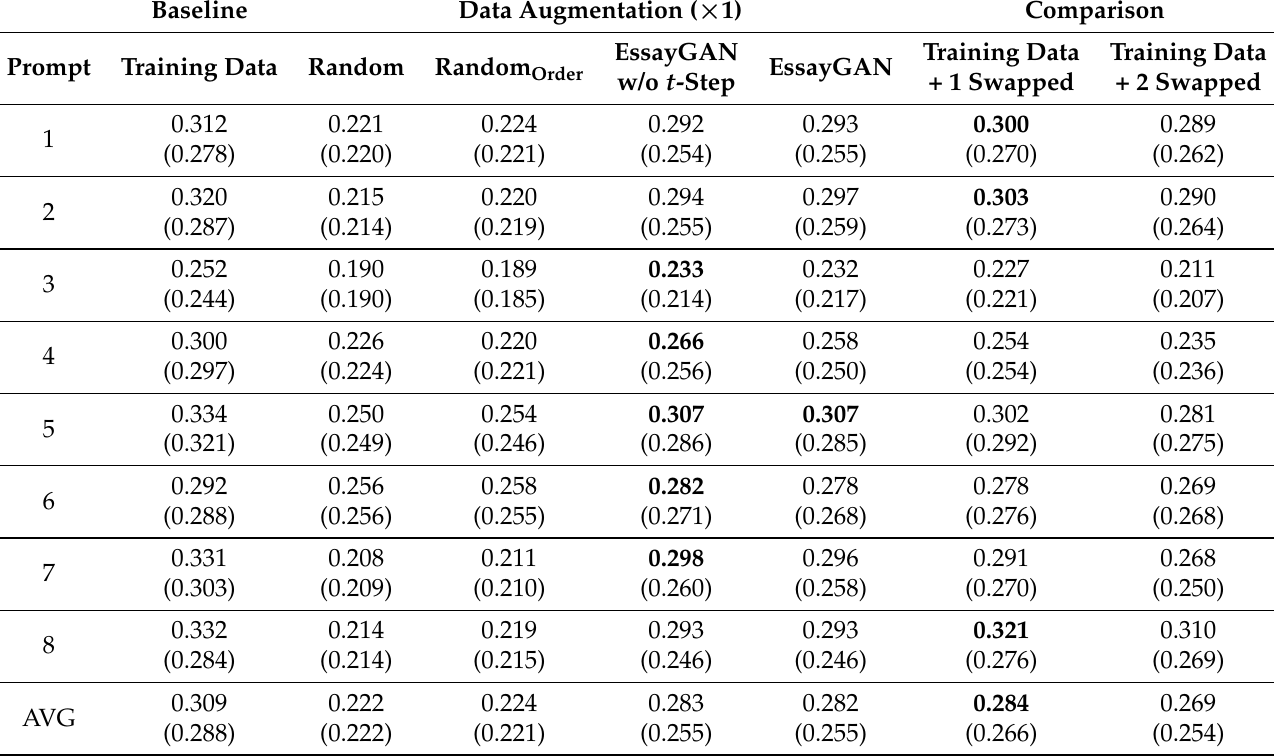
Table 5. Comparison of local and global coherence between sentences in essays according to the augmentation techniques. ‘Training Data + 1 swapped’ refers to a real essay in which one sentence was replaced with a random sentence. ‘Training Data + 2 swapped’ refers to one with two swapped sentences. The numbers inside parentheses are values of global coherence. Boldface indicates the highest values of coherence, excluding the ‘Training